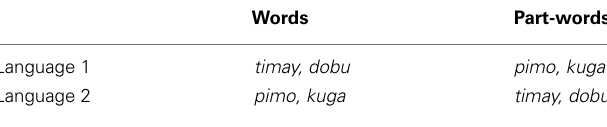
Table 1 |Word and part-word test items for Experiments 1 and